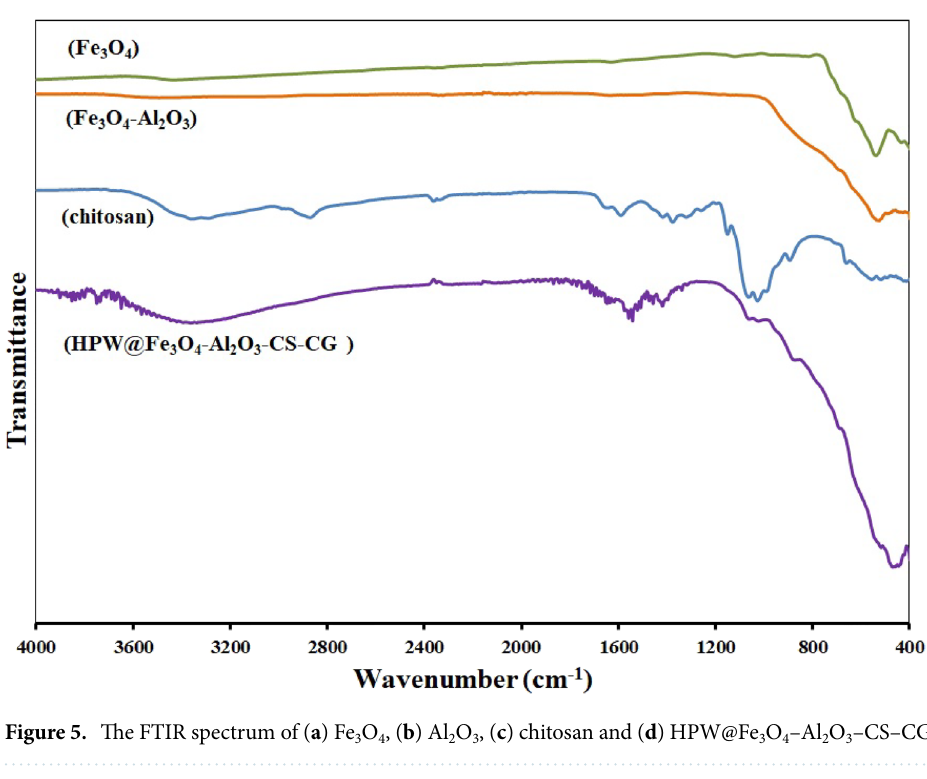
Figure 5. The FTIR spectrum of ( a ) Fe 3 O 4 , ( b ) Al 2 O 3 , ( c ) chitosan and ( d ) HPW@Fe 3 O 4 –Al 2 O 3 –CS–CG.